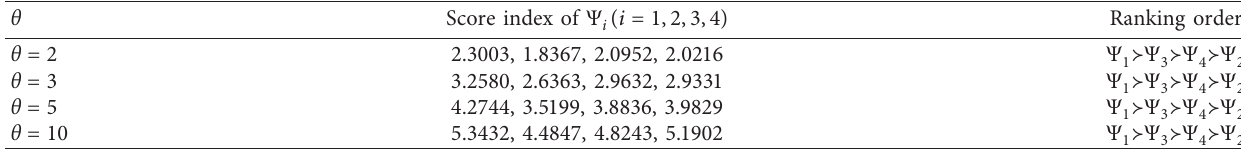
Table 5: The influence of parameter θ on the rank of alternatives ( p � q � 1 ) .